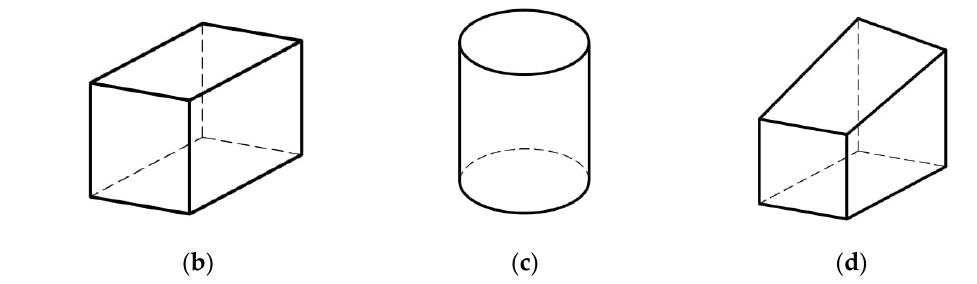
Figure 10. Typology of glass form: ( a ) cubes; ( b ) cuboids; ( c ) cylinders; and ( d ) free-forms (figures by the author).